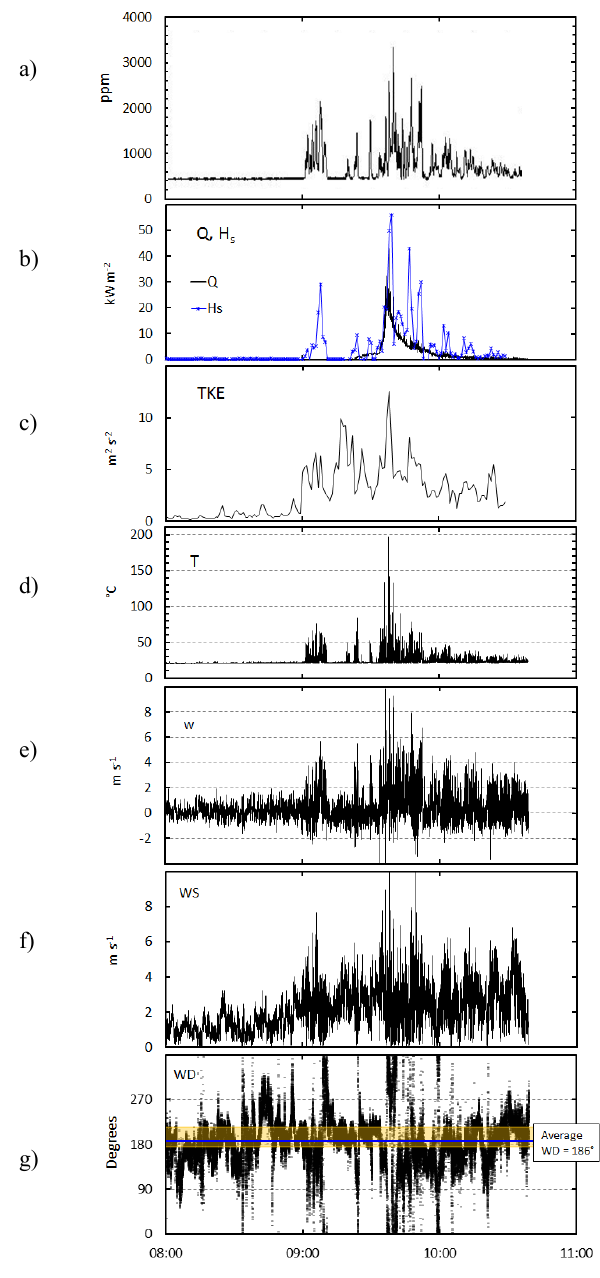
Fig. 4. Observations within the burning area during the flaming phase. (a) CO 2 concentrations, (b) heat flux (Q), turbulent sensi- ble heat flux (Hs), (c) turbulent kinetic energy (TKE), (d) temper- ature ( T ), (e) vertical flow velocity ( w ), (f) horizontal wind speed (WS), and (g) wind direction (WD) at direction (WD) at 12m above ground level. The 3-D wind data are at 10Hz, time resolution. The yellow shading indicates the wind direction sector that would bring smoke from the fire to SMEAR